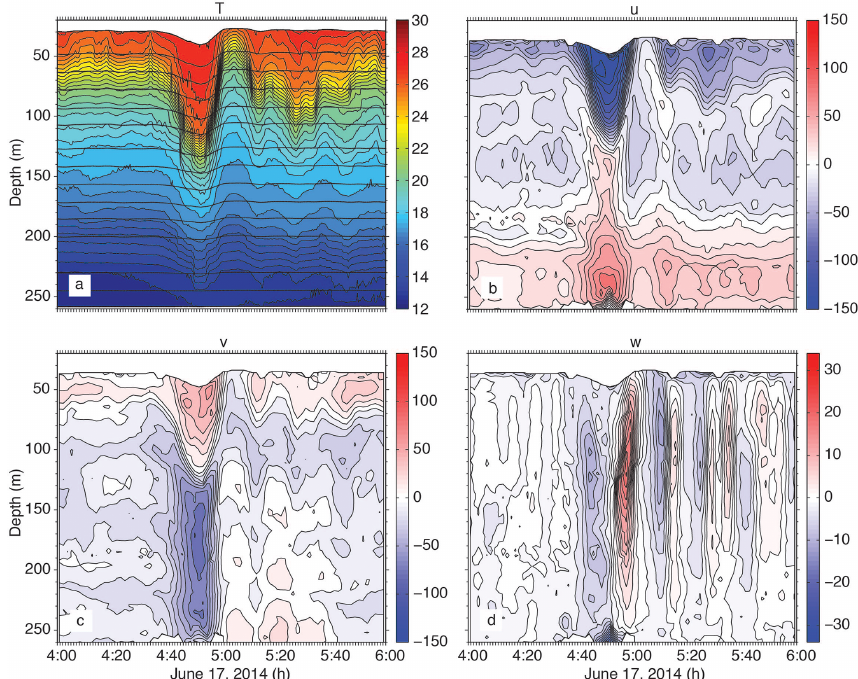
Figure 13. As in Fig. 12 but for wave A9 on 17 June 2014. The steepening back side and subsurface velocity maximum suggest breaking or imminent breaking.